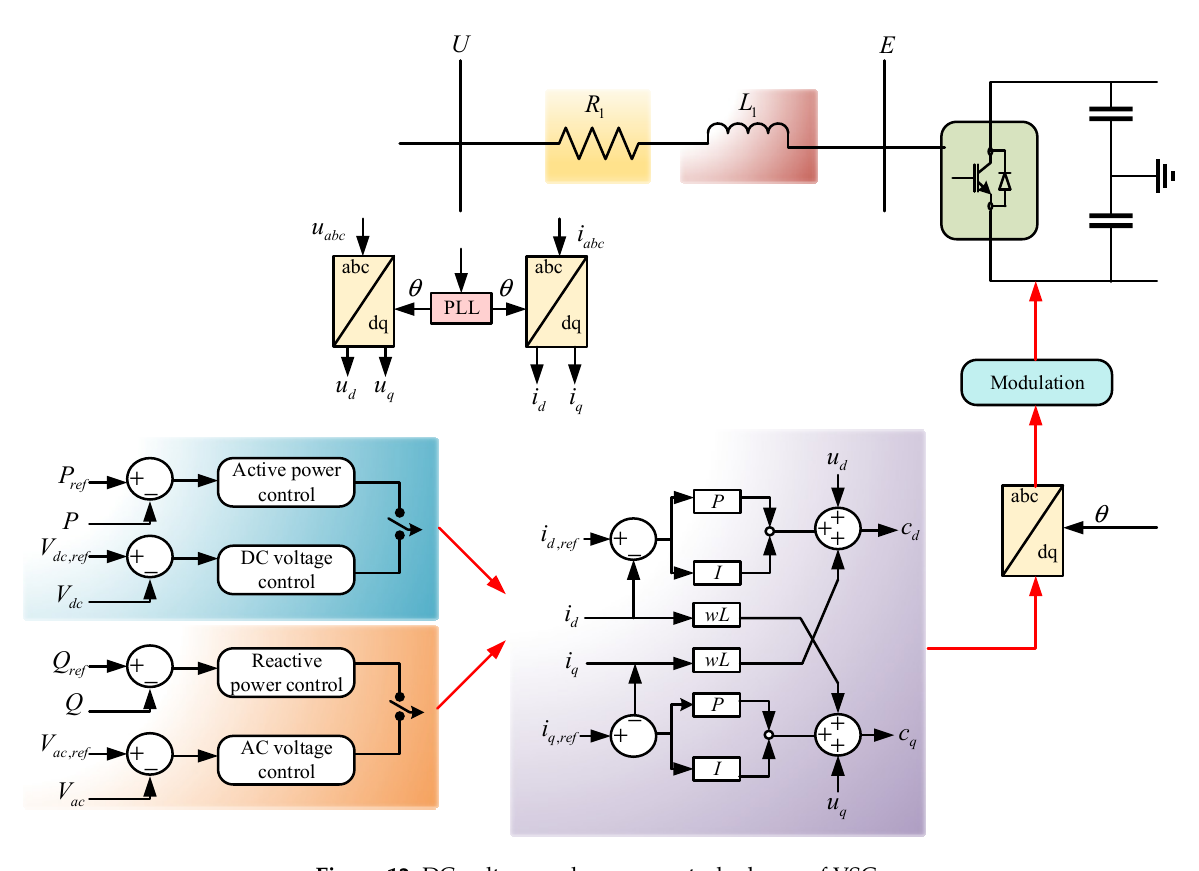
Figure 12. DC voltage and power control scheme of VSC.